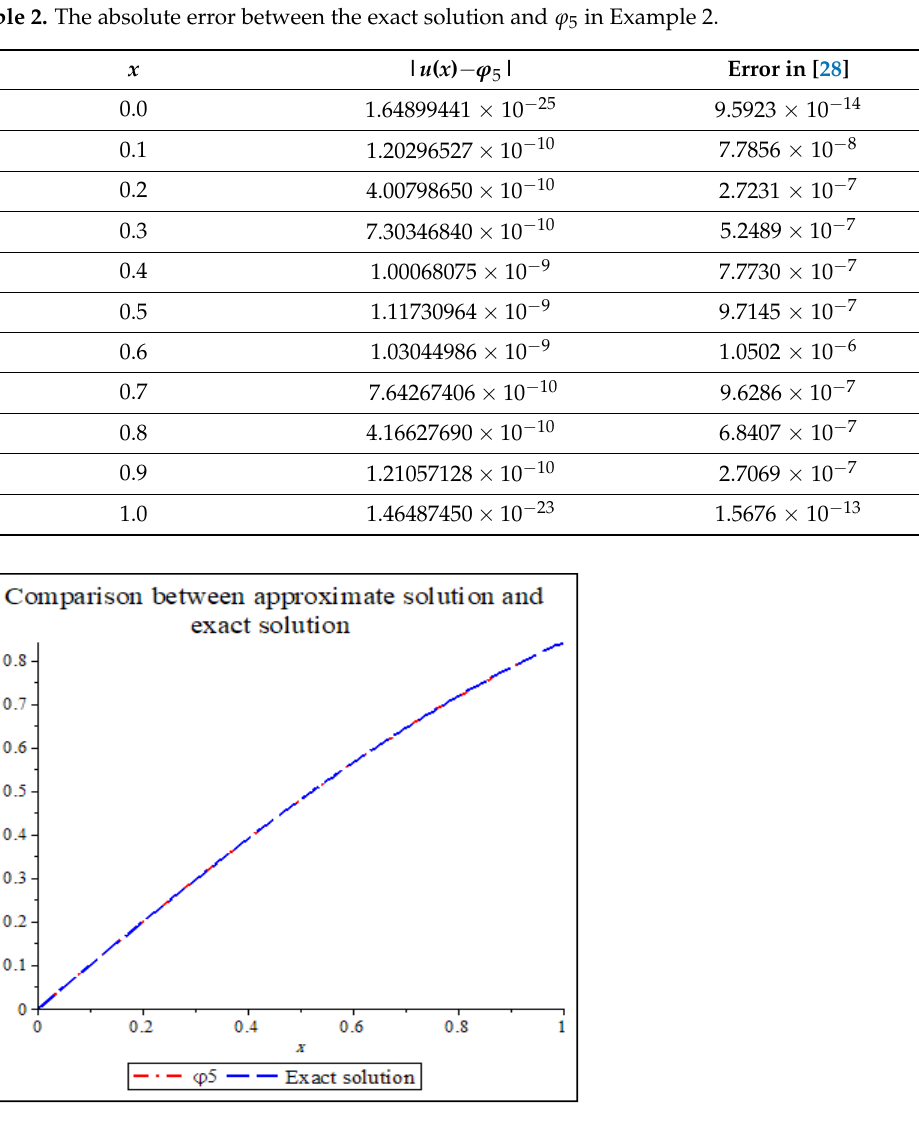
Figure 2. Comparison of the exact solution and the approximate solution 𝜑 (cid:2873) in Example 2.